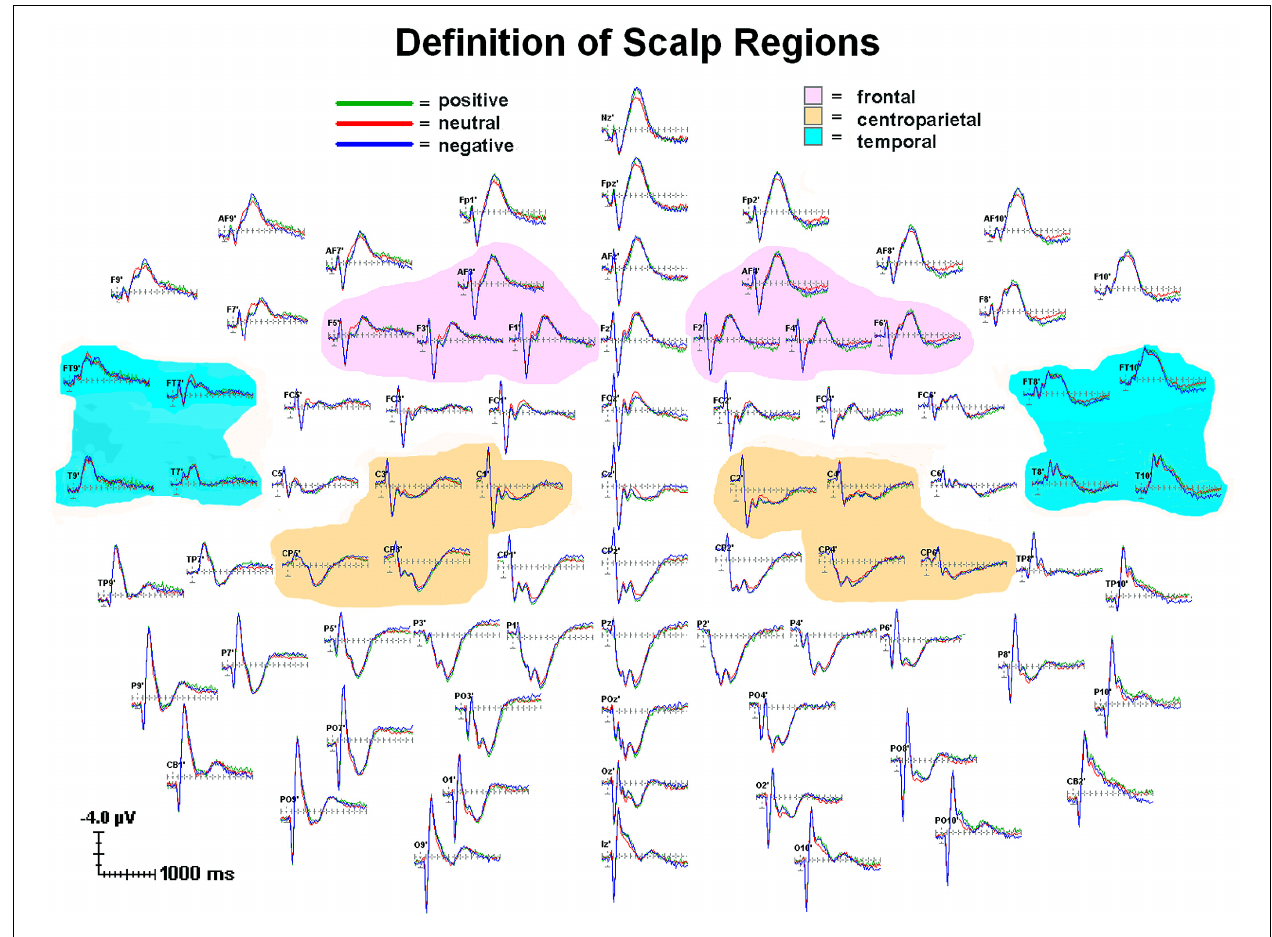
FIGURE 2 | Grand average ( n = 88) for each emotion condition showing scalp topography for individual channels and regional groupings of channels. All channels relative to an average reference.Waveforms from